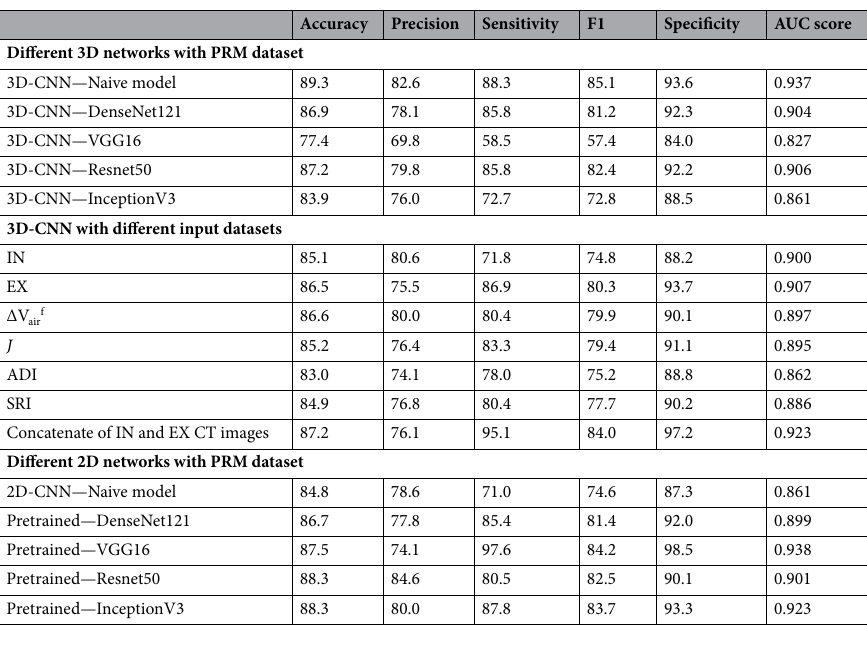
Table 2. Performances of different 3D networks on the PRM dataset, the same 3D-CNN on different input datasets, and different 2D networks on the PRM